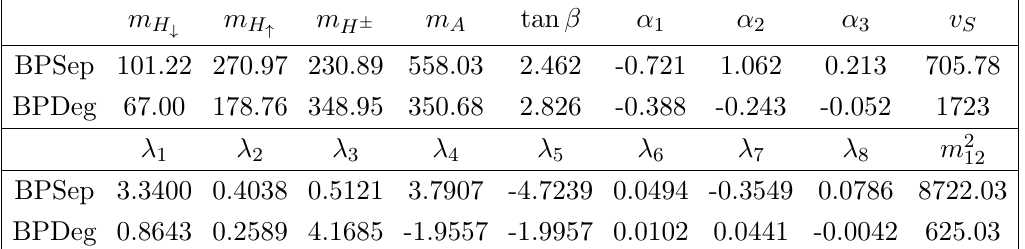
Table 7 . N2HDM T1 benchmark points BPSep and BPDeg with semi-inverted mass hierarchy. The masses and the singlet VEV v s are given in